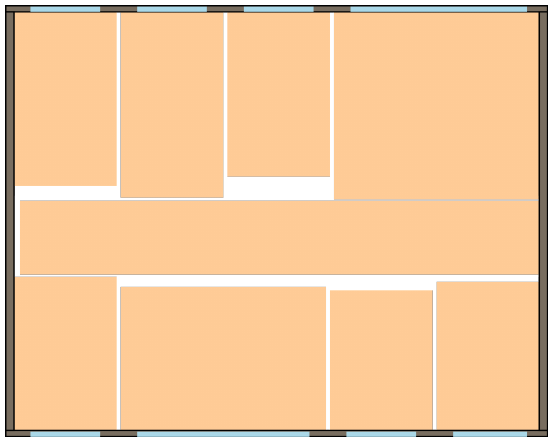
Figure 1: Topological floorplan model derived using constraint